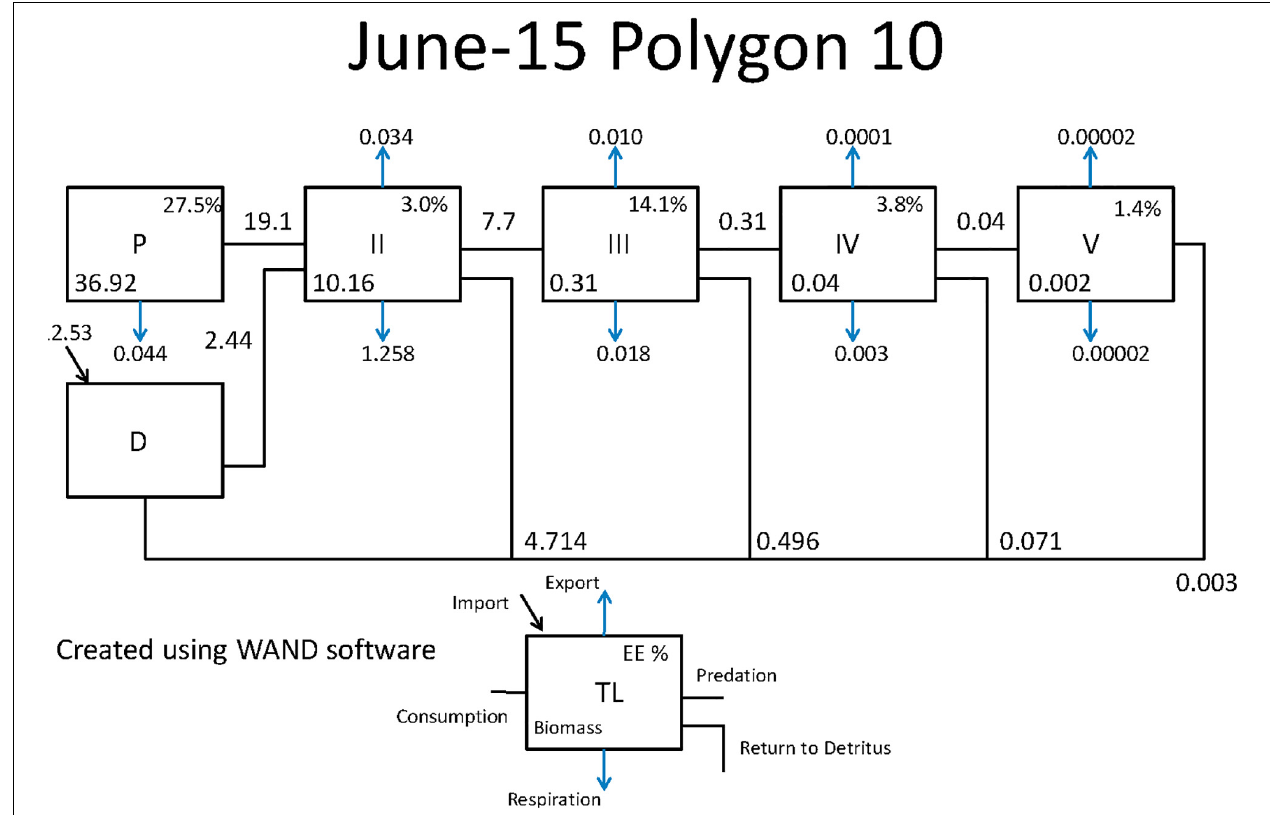
FIGURE 7 | Example Lindeman Spine diagrams from the CASM model for polygon 10 on June 15. Biomasses are t km − 2 and flows are in t km − 2 day − 1 (Allesina and Bondavalli,